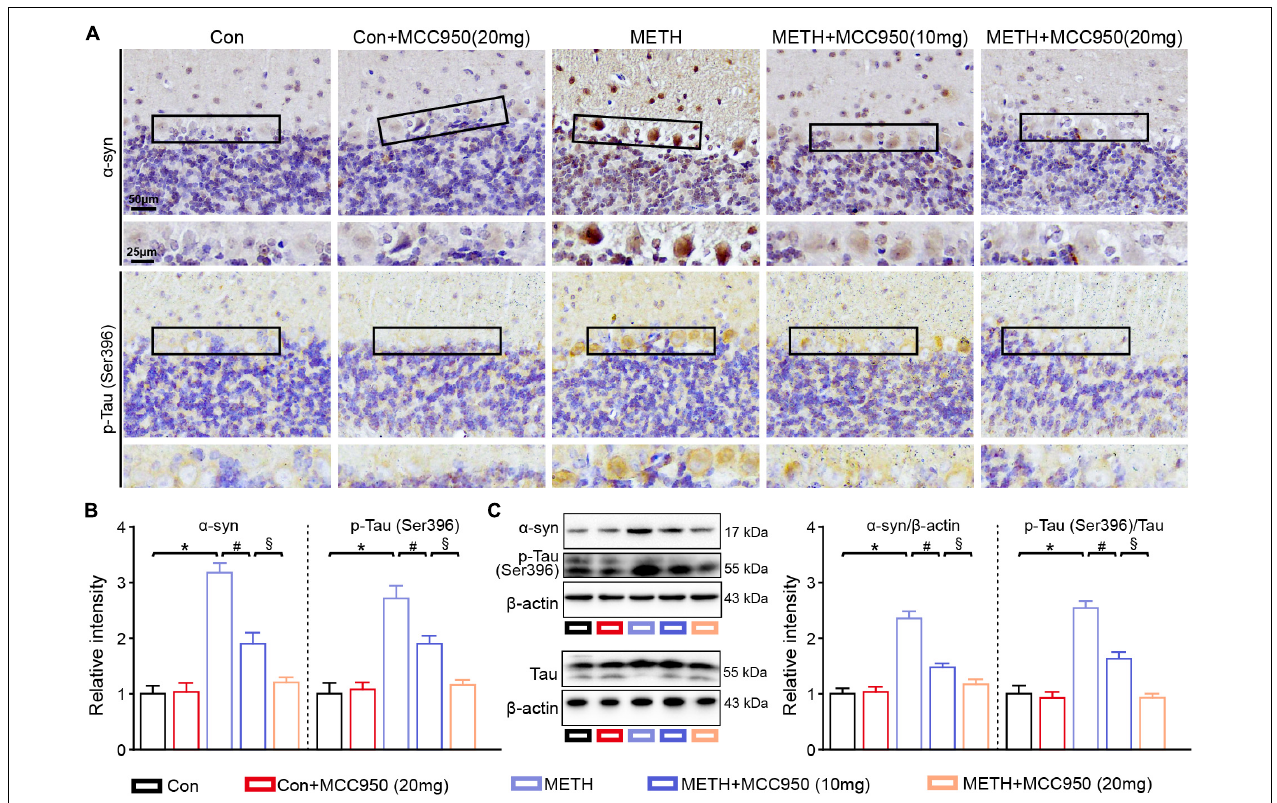
FIGURE 3 | MCC950 reversed α -syn and p-Tau level increasing. (A) Representative images of α -syn and pSer396-Tau IHC staining. (B) Relative intensity of α -syn and pSer396-Tau in cerebellar areas. (C) Western blot and quantification for α -syn and pSer396-Tau in cerebellum. n = 6 per group by one-way ANOVA and Bonferroni’s post-hoc analysis, * p < 0.05, compared with the Con group; # p < 0.05, compared with the METH-treated group; § p < 0.05, compared with the METH + MCC950 (10 mg)